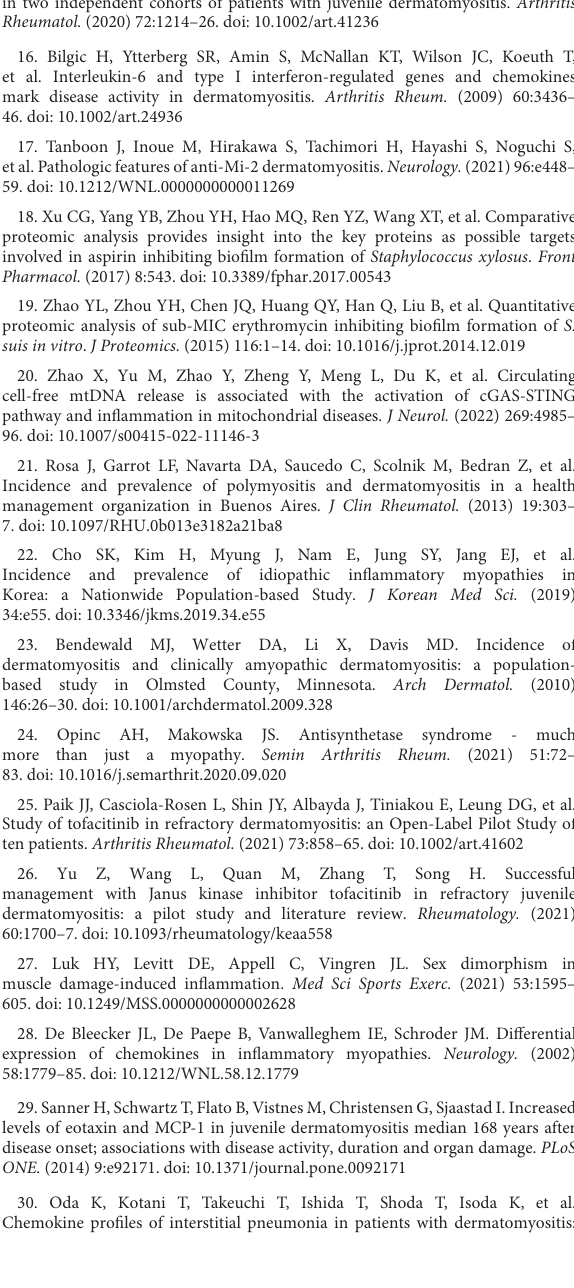
characteristic curves of serum IL-1b. (G) Receiver operating characteristic curves of serum CCL1. (H) Receiver operating characteristic curves of serum CXCL11. (I) Receiver operating characteristic curves of serum CCL3. (J) Receiver operating characteristic curves of serum IL-8. (K) Receiver operating characteristic curves of serum CXCL9. (L) Receiver operating characteristic curves